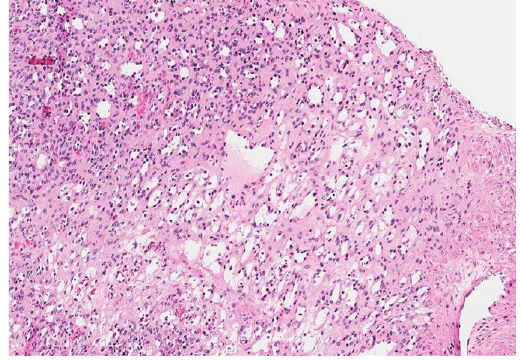
Figure 6 - Histologic sample of the ressected lesion shows anastomosing proliferation of capillary sized vessels, reminiscent of splenic sinusoids and scattered hobnailed endothelial cells, confirming the diagnosis of an anastomosing